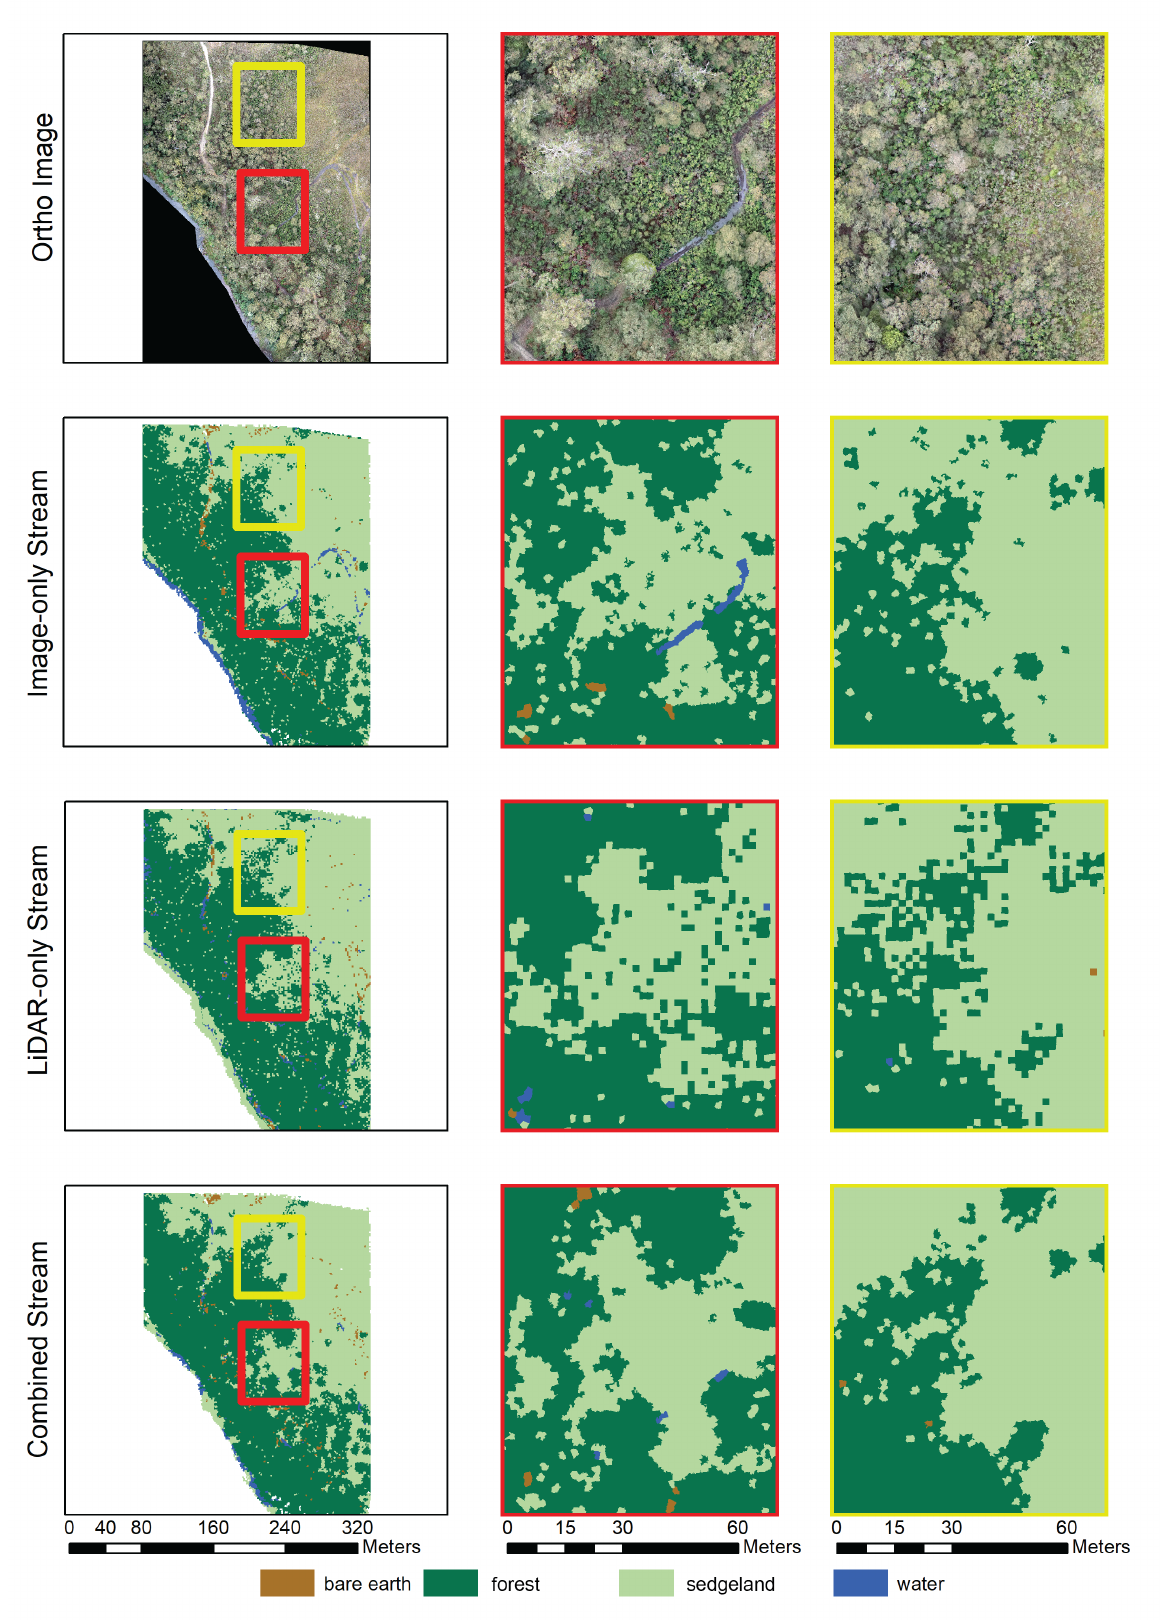
Figure 2. Ortho images of the study area and two focused areas. Maps demonstrating the vegetation classification of the image-only data stream, LiDAR-only data stream and combined data